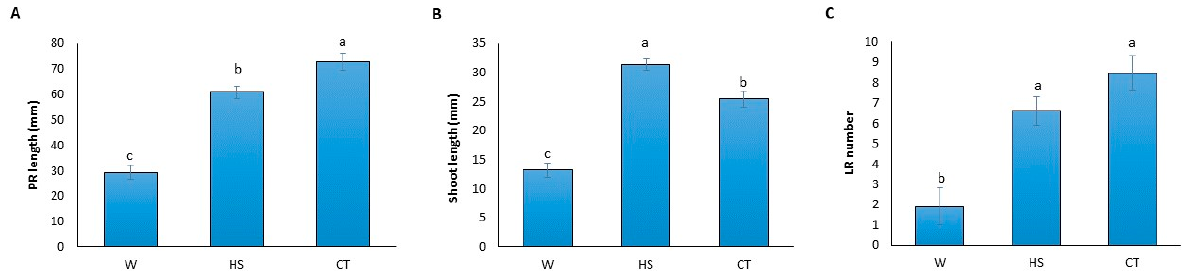
Figure 1. Root and shoot development were modified by adding CT. Primary root (PR) length ( A ), shoot length ( B ) and lateral root (LR) number ( C ) were determined in ten-day-old tomato seedlings grown under water (W), Hoagland solution (HS) and compost tea (CT) treatments. The data show the mean ± standard error. Different letters showed statistically significant differences among the different treatments according to Tukey’s HSD post-hoc test ( p < 0.05).